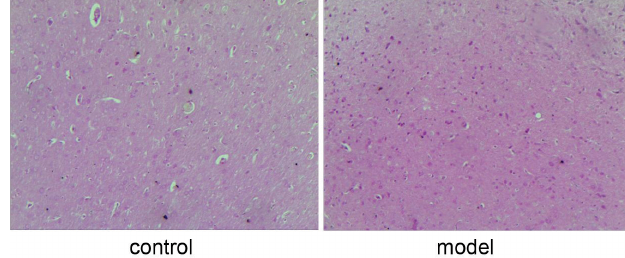
FIGURE 7 - Pathological section of brain in 4 th week (HE×100).